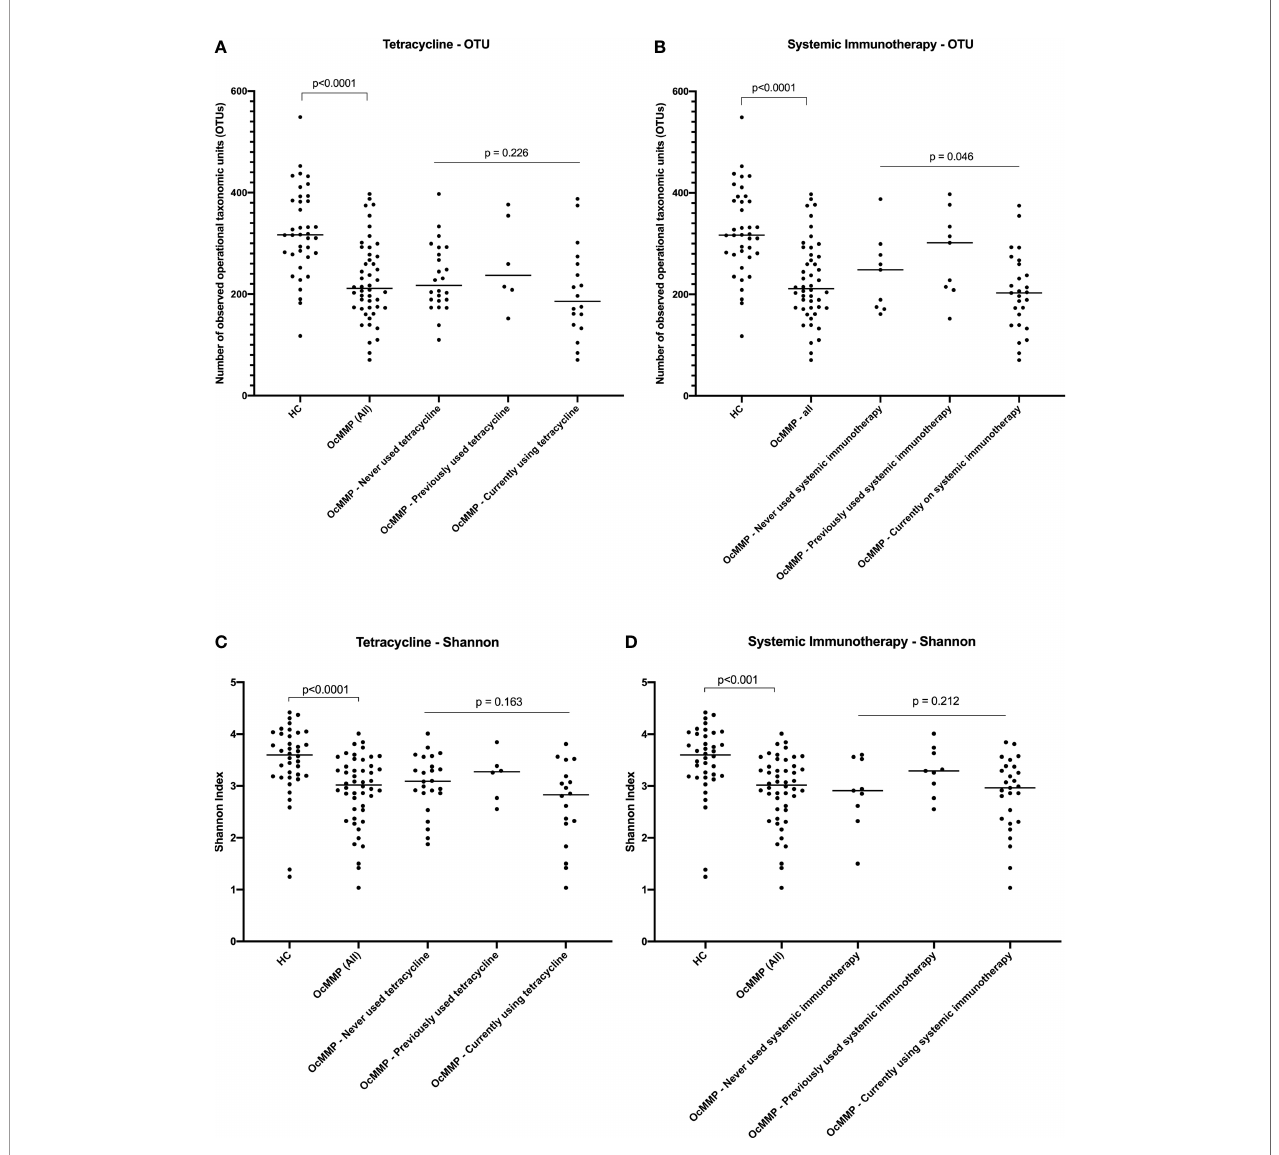
FIGURE 1 | Comparisons in alpha diversity between healthy volunteers and OcMMP. Comparisons between the HC and OcMMP groups were initially performed using Mann-Whitney U tests. The OcMMP group was then divided into three subgroups, based on systemic immunotherapy usage, and comparisons between these subgroups were performed using Kruskal-Wallis tests. Comparisons in observed operational taxonomic units (OTUs) and Shannon Index between healthy controls and OcMMP, with subsets of OcMMP patients in relation to their use of low-dose oral tetracycline (A, C) , and use of systemic immunotherapy (B, D) . Patients with OcMMP had signi fi cantly lower number of OTUs and Shannon Index compared to healthy controls. No signi fi cant differences in number of OTUs or Shannon Index were detected between OcMMP patients who had never used, previously used or currently on long-term, sub antimicrobial dose of oral tetracycline, known to exert anti-in fl ammatory effects through its matrix metalloproteinase inhibitor properties (A, C) . Patients who were currently on systemic immunomodulatory therapy had lower observed OTUs compared to those who had never used or had previously used systemic immunotherapy, however, there was no signi fi cant difference in the Shannon Index for these patients (B, D)